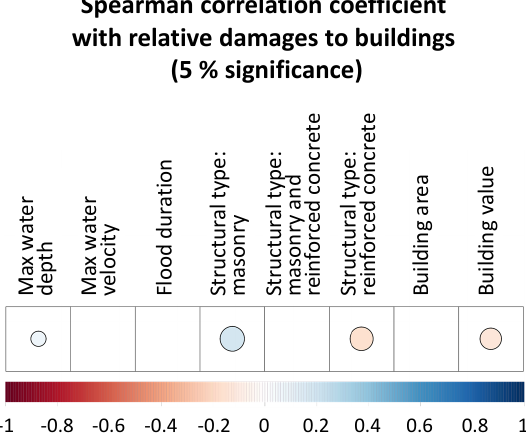
Figure 5. Spearman correlation between relative loss (buildings only) and predictive variables: maximum water depth, maximum water velocity, flood duration, structural type (masonry, masonry and reinforced concrete, or reinforced concrete), building area and building value per unit area. Empty boxes indicate statistically non- significant correlation coefficients at a 5% significance